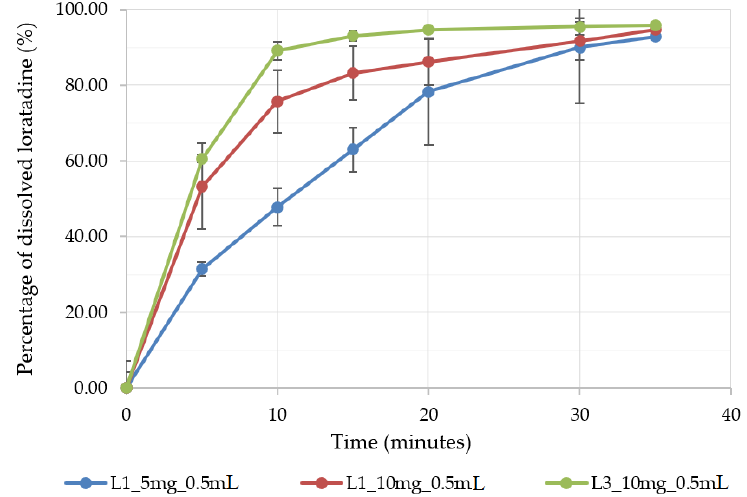
Figure 7. The dissolution profile of three selected OL formulations prepared in 0.5 mL alveolae.